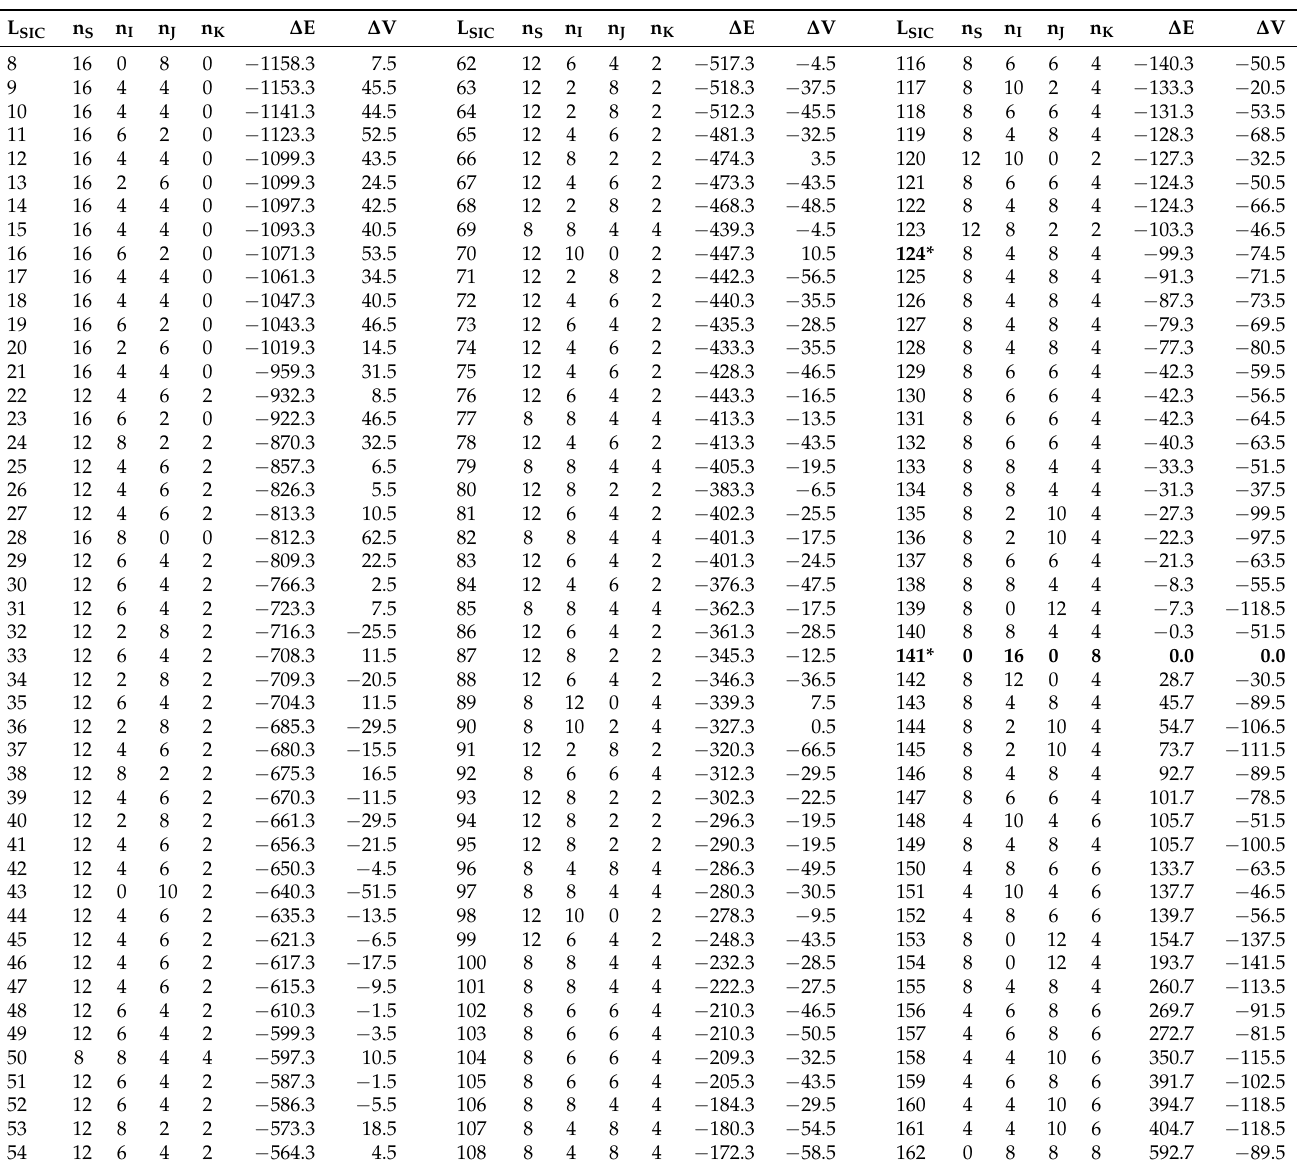
Table A4. B3LYP relative energy ( ∆ E in µ E h per 2 f.u.) and volume ( ∆ V in mÅ 3 per 2 f.u.) for